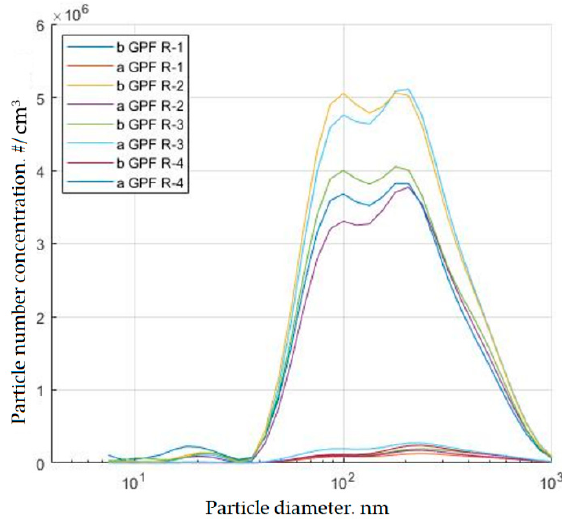
Figure 15. Particle number size distribution for case 1, loading #4. b—before; a—after; R—round.